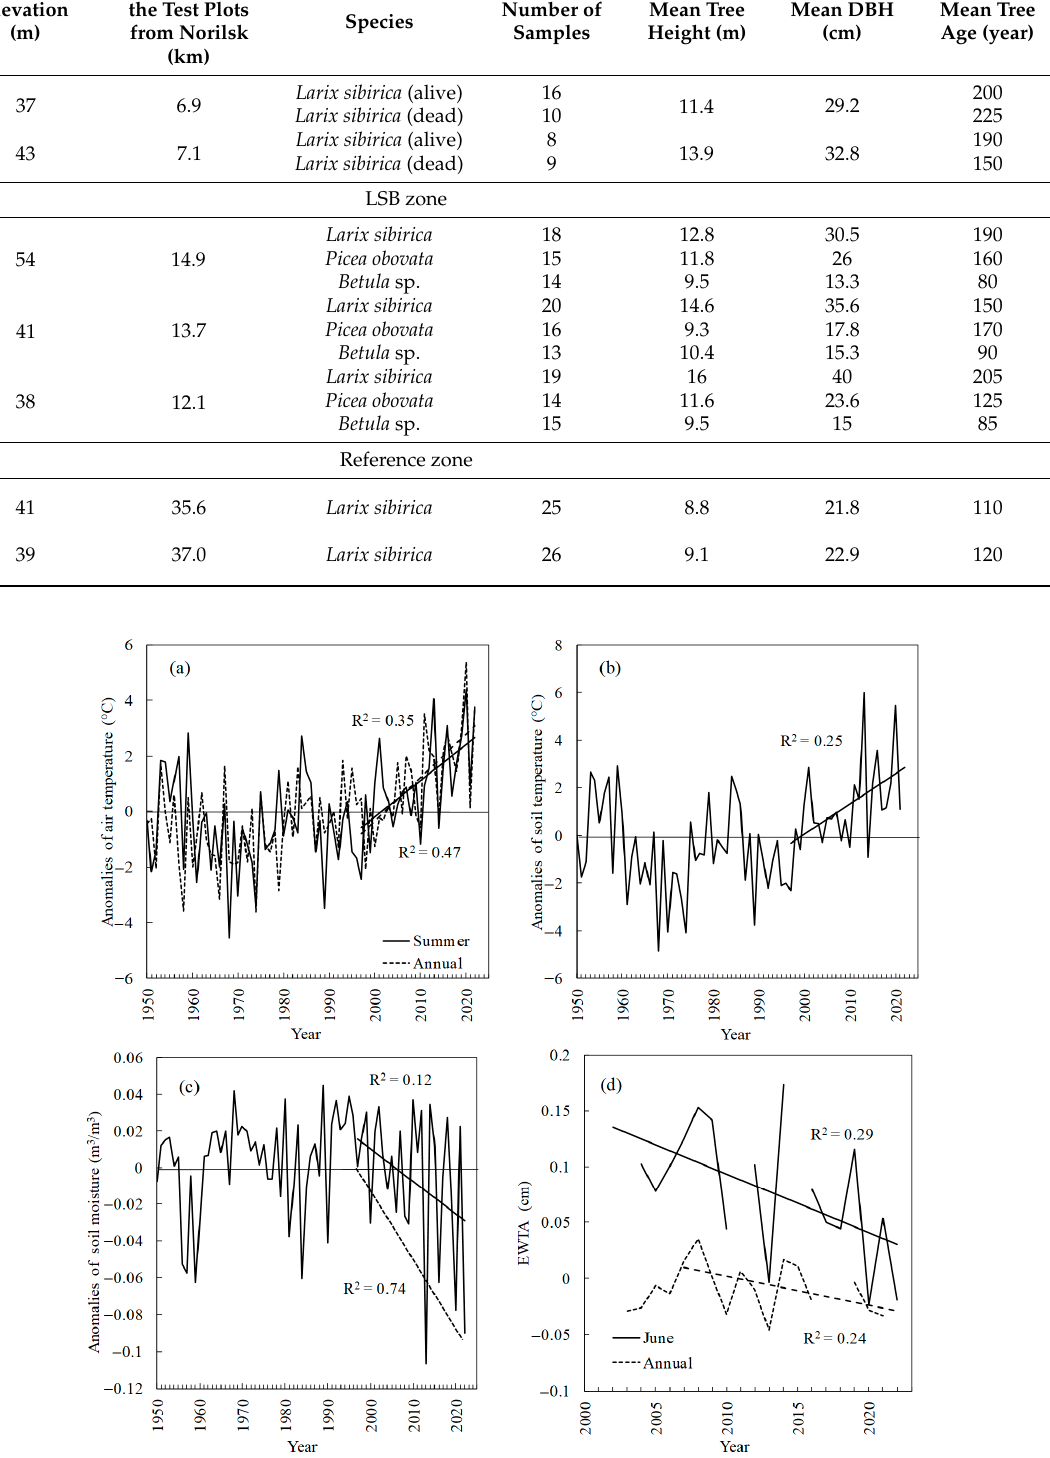
Figure 3. ( a ) Summer (June–August) and annual (January–December) air temperature anomalies. ( b ) Summer soil temperature. ( c ) Summer soil moisture. The dashed line indicates the trend of local minimum values. ( d ) Terrestrial water storage (EWTA, June and annual data). Trends are significant at p < 0.05 ( a , b ) and p < 0.1 ( c , d ).